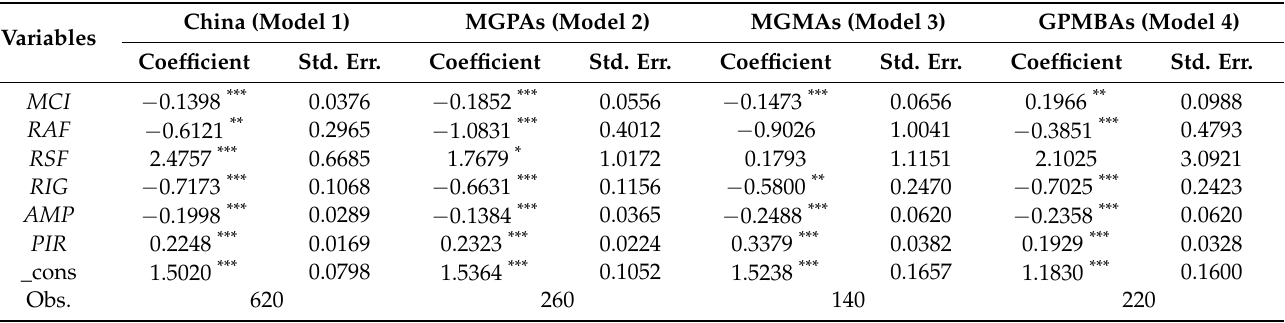
Table 7. Tobit regression results for China, main grain producing areas (MGPAs), main grain marketing areas (MGMAs), and grain producing and marketing balance areas